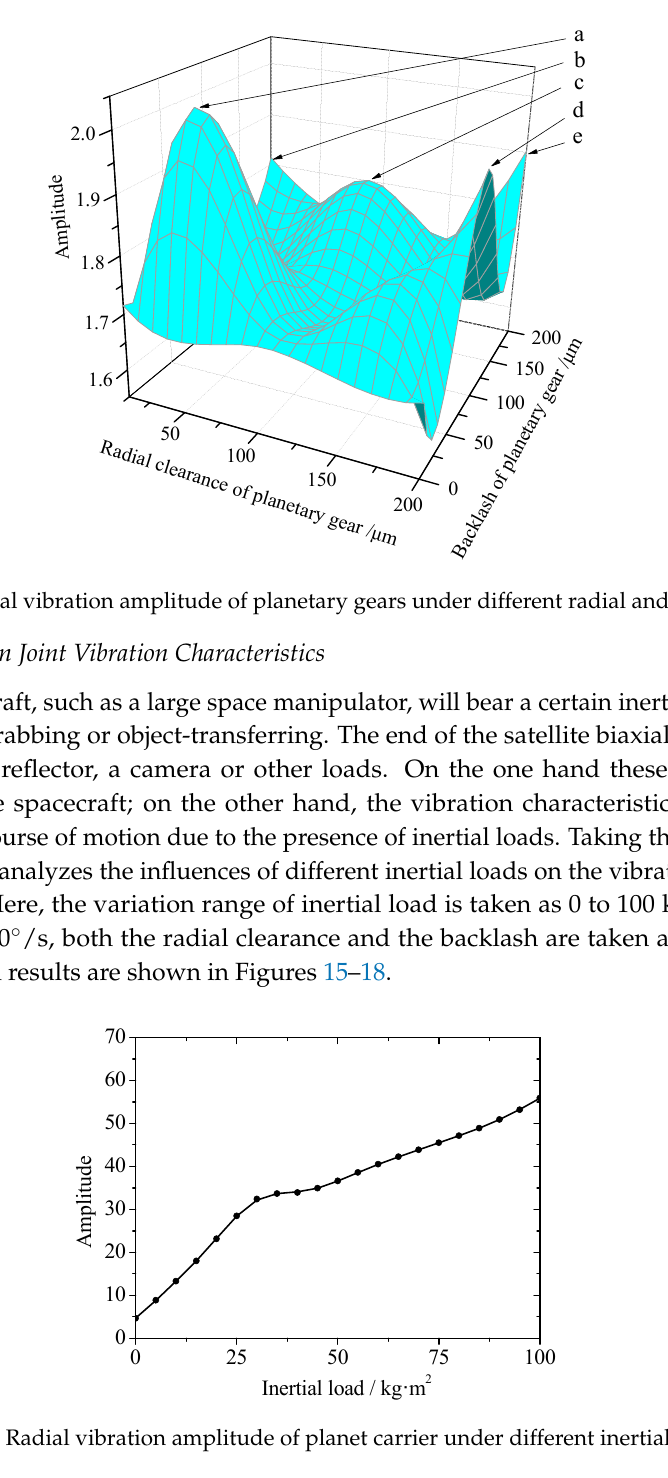
Figure 16. Radial vibration amplitude of planetary gear under different inertial loads.